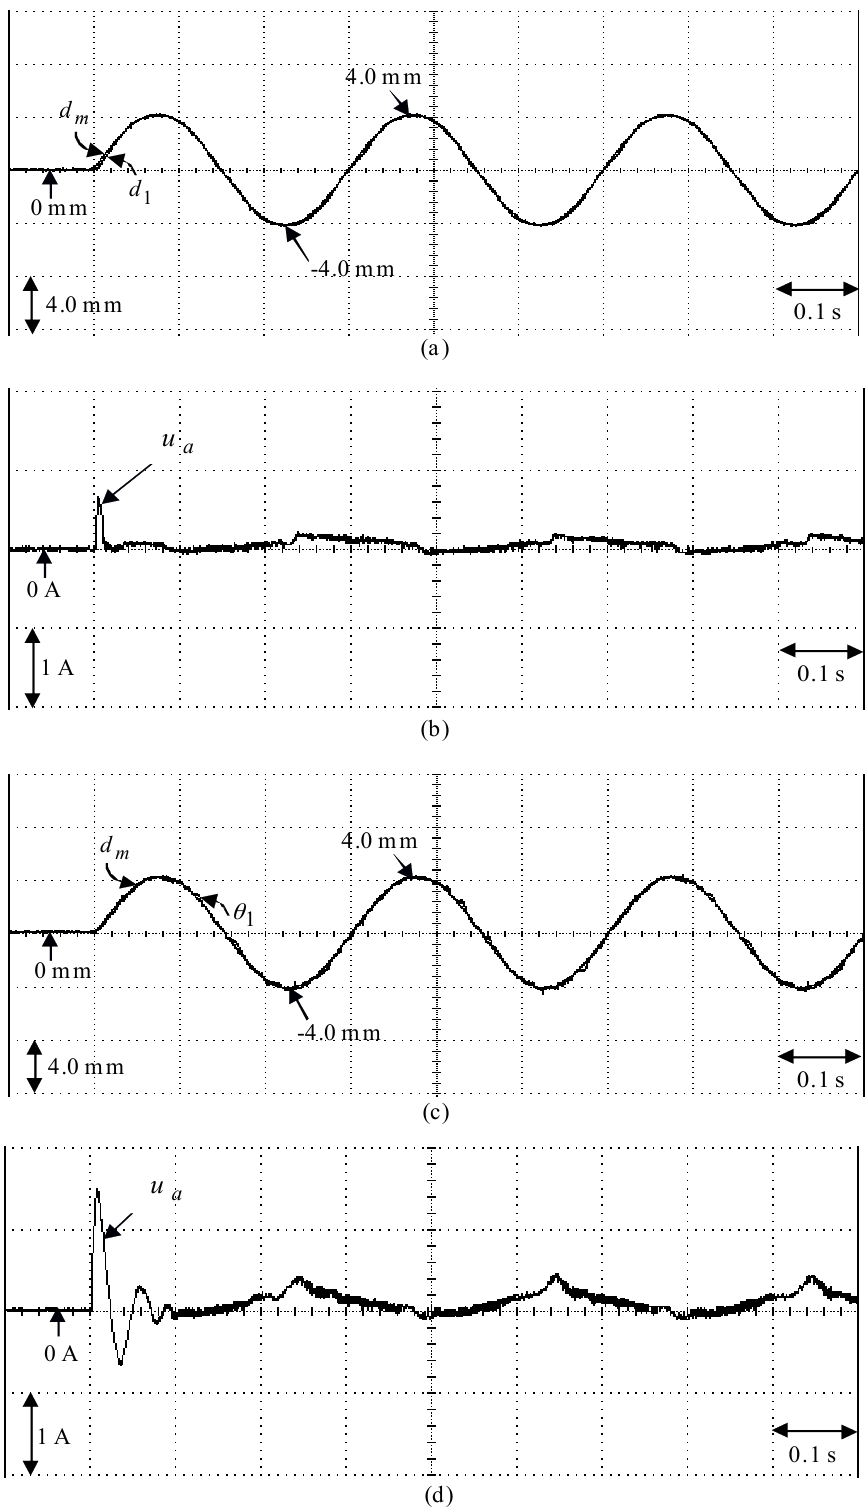
Figure 10. Experimental results of the eminent PI controller due to periodic sinusoidal command from − 4.0 mm to 4.0 mm: ( a ) position reaction of the mover in Case 3, ( b ) reaction of control effort in Case 3, ( c ) position reaction of the mover in Case 4, ( d ) reaction of control effort in Case 4.